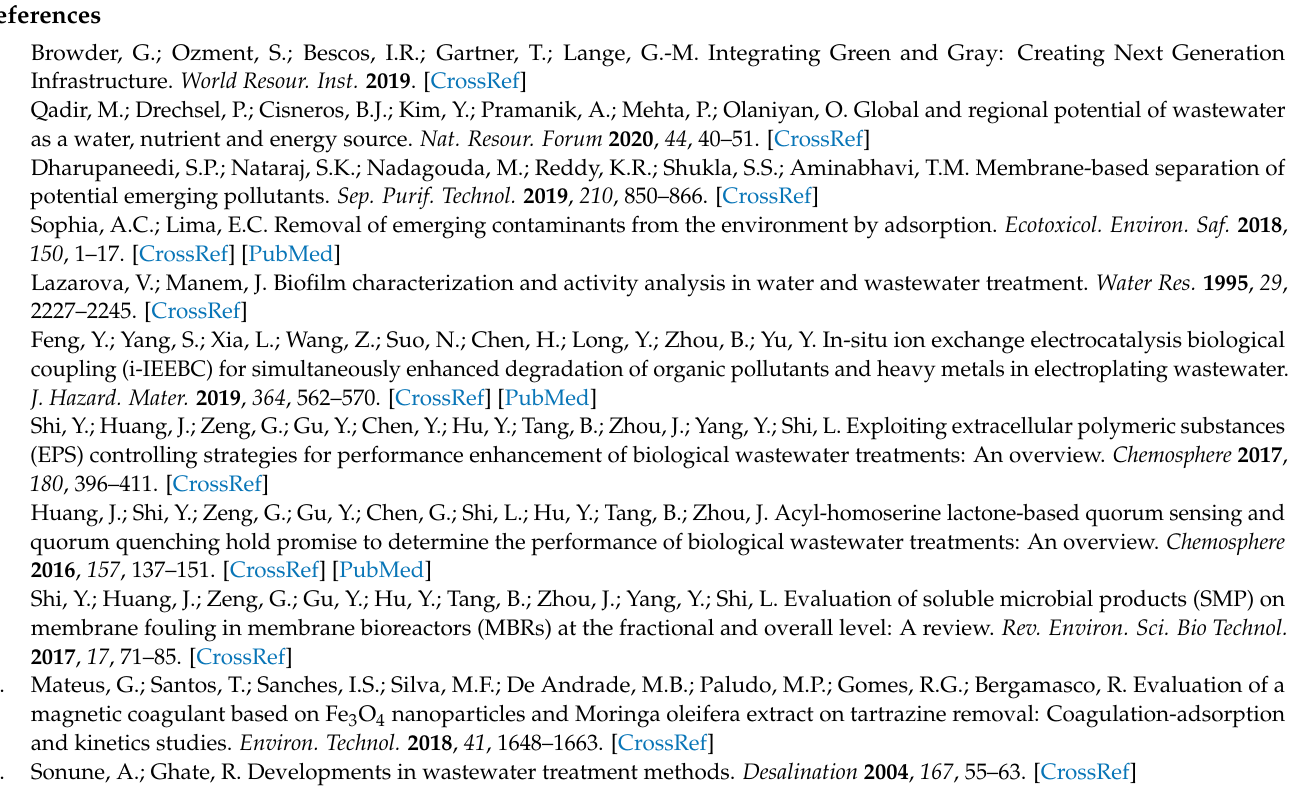
Figure 10), greater photodegradation efficiency (98.1%: Figure 11), superior flux recover ratio (91.78%: Figure 14), as well as lowest total and fractional resistances (Figure 14).